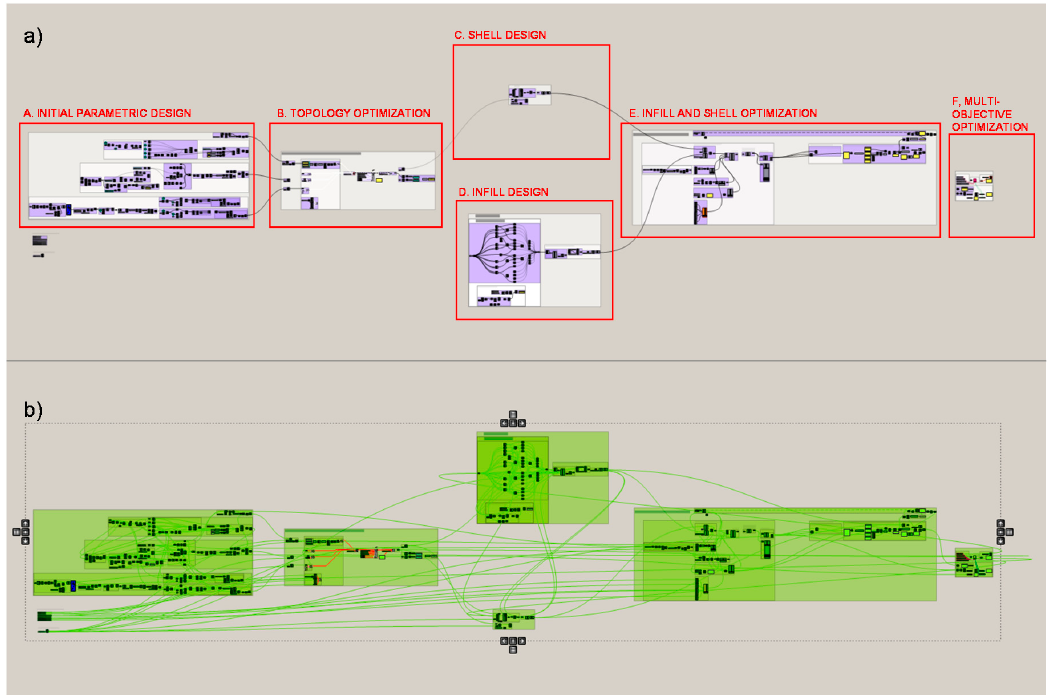
Figure 4. Programming structure definition of the proposed methodology for the case study developed with Grasshopper. ( a ) Structure diagram, ( b ) Data flow.